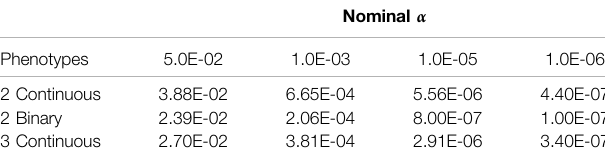
TABLE 1 | Simulation studies of Type I error estimates when testing the linear association between a single SNP and a product of phenotypes using pre- and 10 − 6 . Each entry represents the proportion of p -values smaller than α when modeling the linear relation between a SNP and a product of